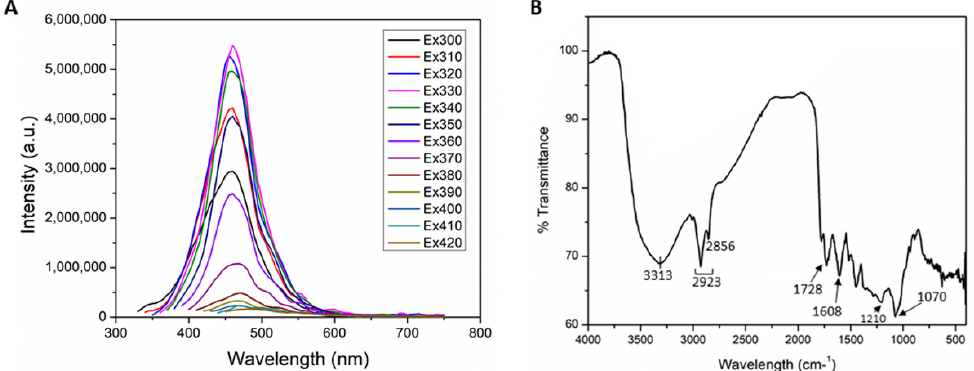
Figure 2. ( A ) Fluorescence emission spectra of the CDs at different excitation wavelengths. ( B ) FTIR spectrum of the CDs.